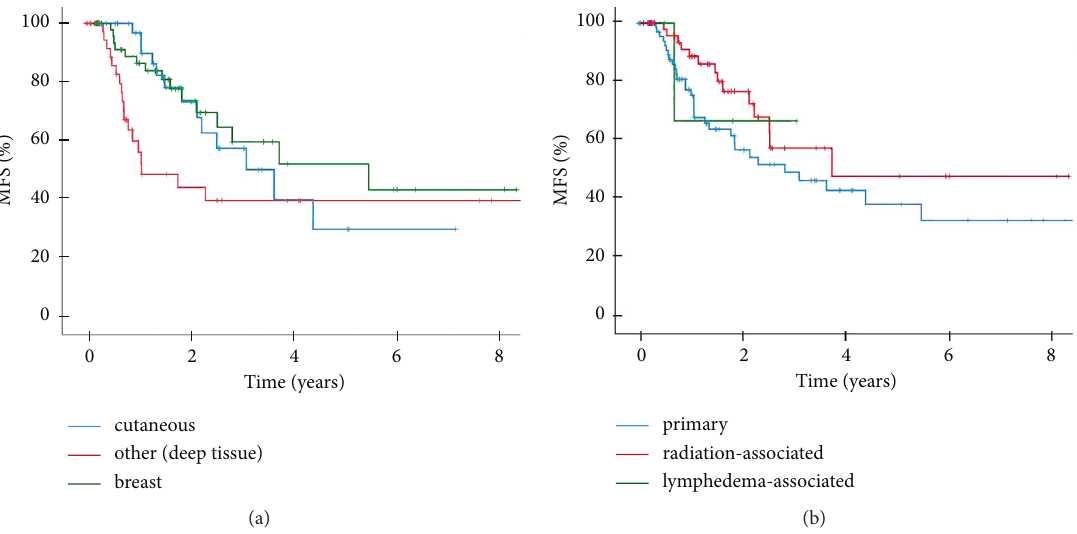
Figure 3: Metastasis-free survival (MFS). Kaplan–Meier curves showing 8-years MFS (a) comparing deep soft tissue angiosarcomas ( N � 46), cutaneous angiosarcomas ( N � 37), and angiosarcomas of the breast ( N � 52) with a median MFS of 13.0 vs. 44.0 vs. 66.0 months ( p � 0.068; p � 0.034 ∗ ) and (b) comparing primary ( N � 77) and radiation-associated ( N � 55) angiosarcomas with a median MFS of 34.2 vs. 45.1 ( p �